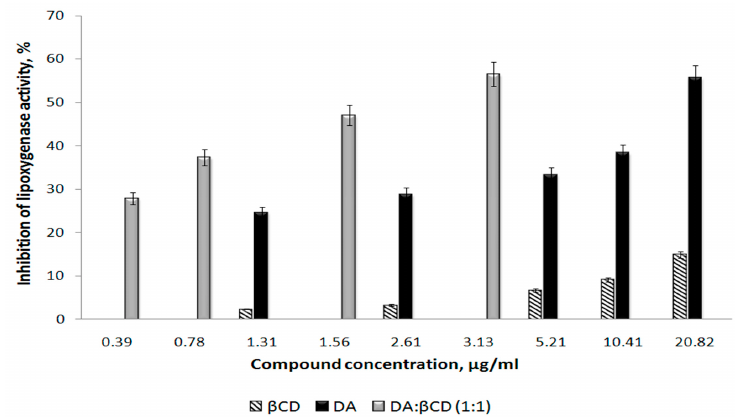
Figure 13. The inhibitory capacity of DA, β CD, and the DA: β CD (1:1 molar ratio) inclusion complex on lipoxygenase activity as a function of DA concentration in the final solution.